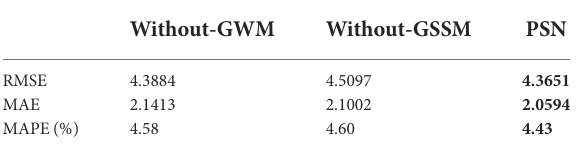
TABLE 6 PEMS04-60 min.